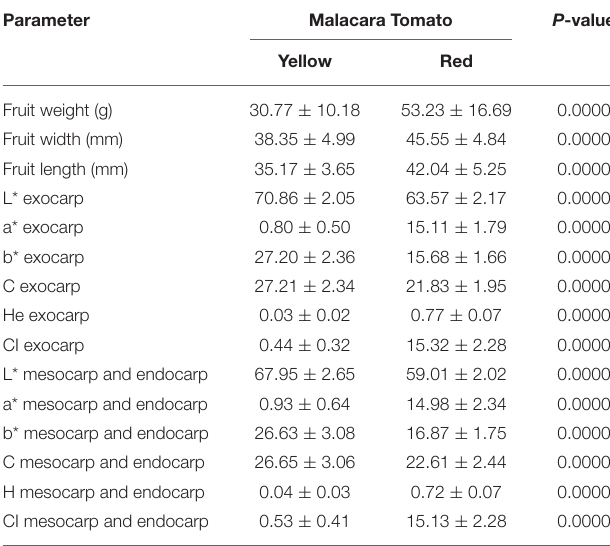
TABLE 1 | Morphological parameters for the two types of Malacara tomatoes (mean SD, n 30 and p ± =